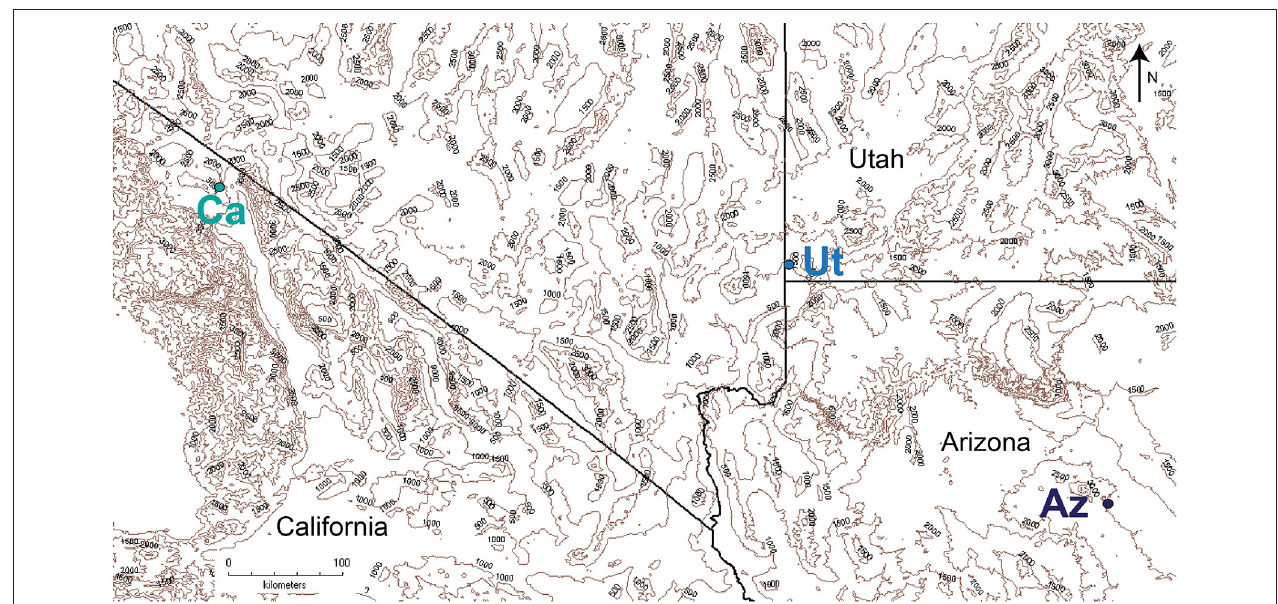
FIGURE 1 | Location of the three wild-type N. attenuata populations used in this study in the western USA. Blue dots indicate locations. Altitude indicated by contour lines at 500m intervals. Map was generated using QGIS v.2.18.